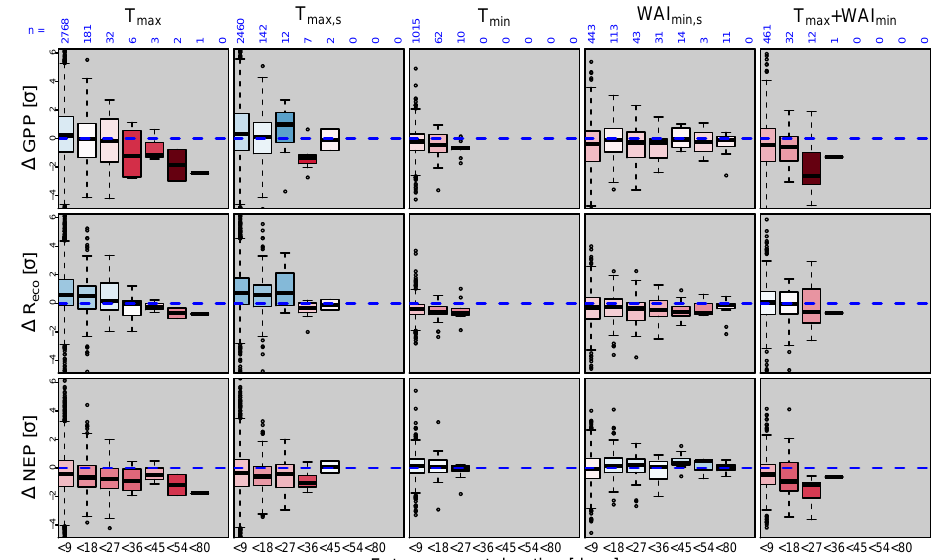
Figure 4. Influence of extreme-event duration on extreme-event impact. Shown are normalized flux differences between extreme events and a reference period ( (cid:49)z = z extr − z ref ; see Eqs. 2 and 3 for details) for gross primary production (GPP), ecosystem respiration (R eco ) and net ecosystem production (NEP) (in rows 1–3) for a selection of different extreme-event types (in columns 1–5: heat (T max ), heat only (T max, s ), cold (T min ), drought only (WAI min, s ), and combined drought and heat (T max + WAI min ); see Table 1 for details on all extreme types). Blue numbers at the top margin of the figure denote the amount of extreme events in each class.